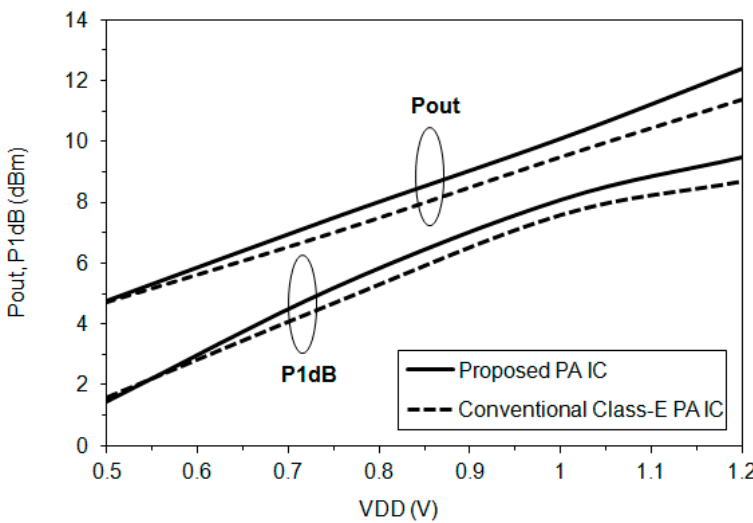
Figure 15. The pout and P1dB of the proposed PA (solid line) and the conventional class-E PA (dotted line) versus supply the voltage variations.